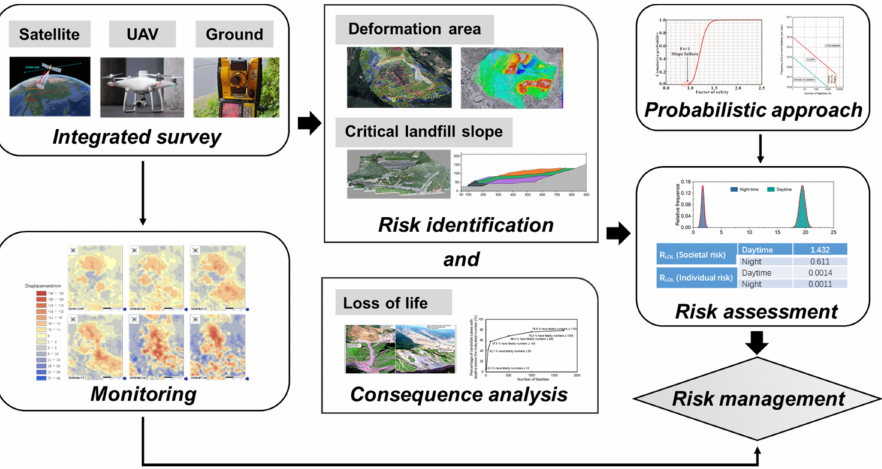
Figure 6. The methodology framework used in this